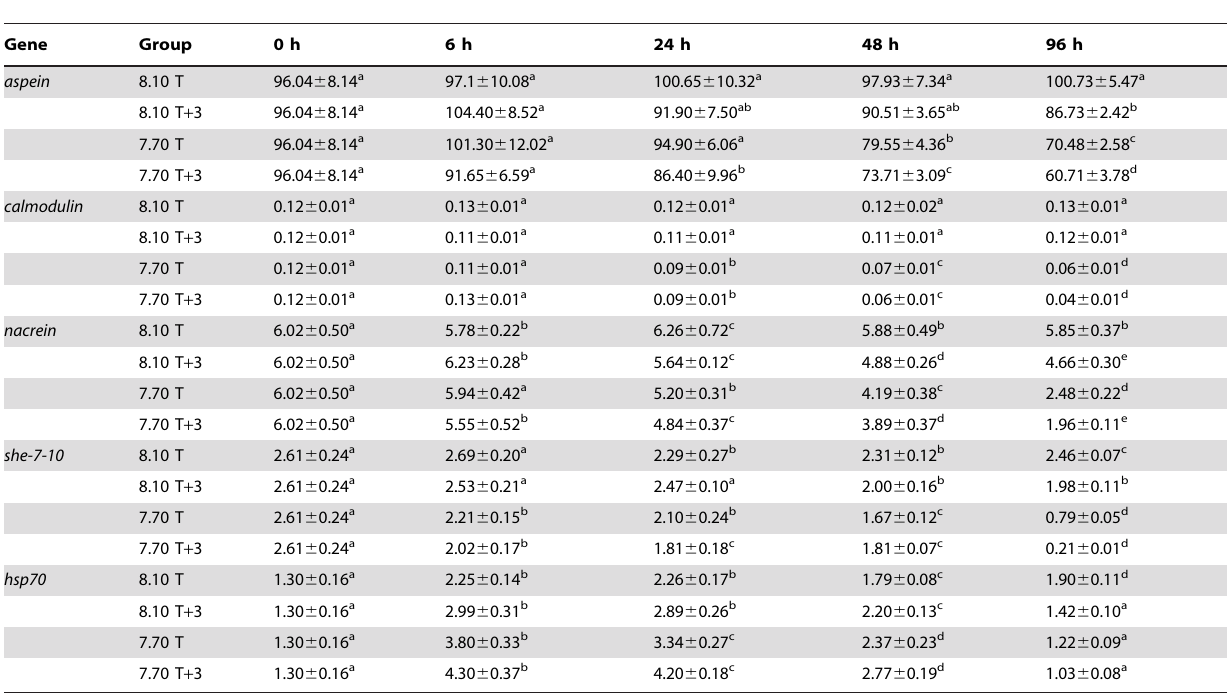
Table 2. Results of statistical tests performed to test the differences of aspein, calmodulin, nacrein, she-7-F10 and hsp70 in Pinctada fucata among different time